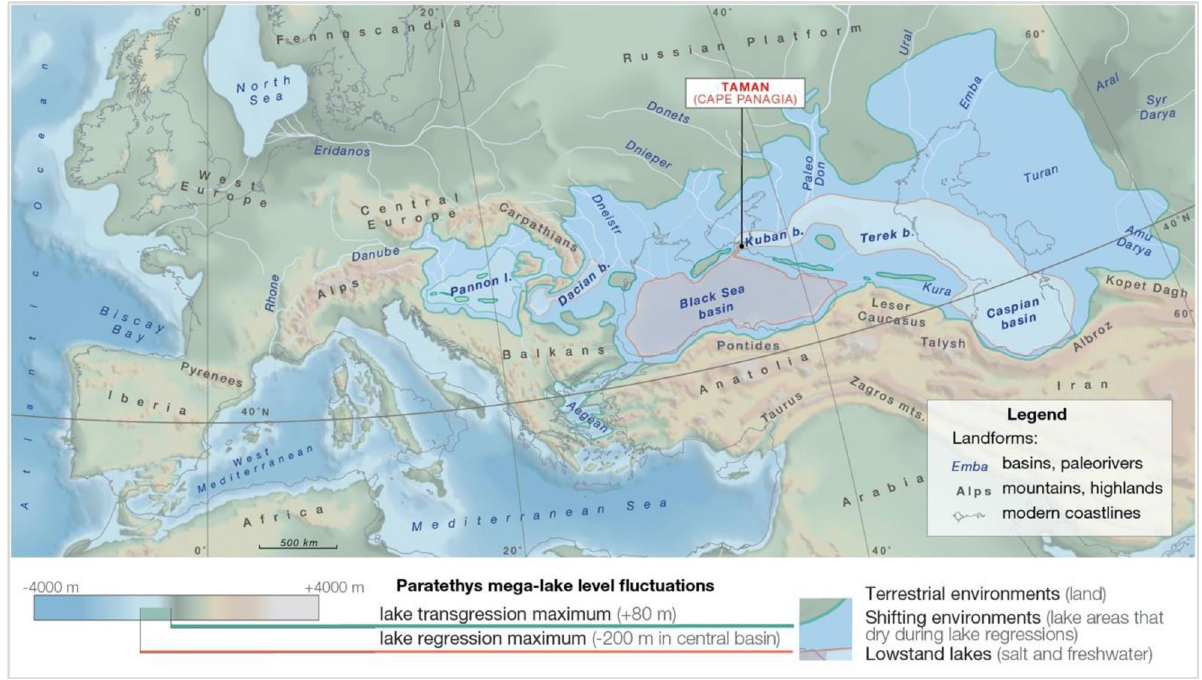
Figure 1. Paleogeographic reconstruction of late Miocene Paratethys fluctuations. During regressive phases, the megalake lost most of its surface. The remaining water was split between a central salt-lake in the Black Sea basin (marked in red) and peripheral basins that periodically refilled and became fresher (light blue) (Map generated in ArcGIS Pro https:// www. esri. com/ en- us/ arcgis/ produ cts/ arcgis- pro/ overv iew, v. 2.1, see